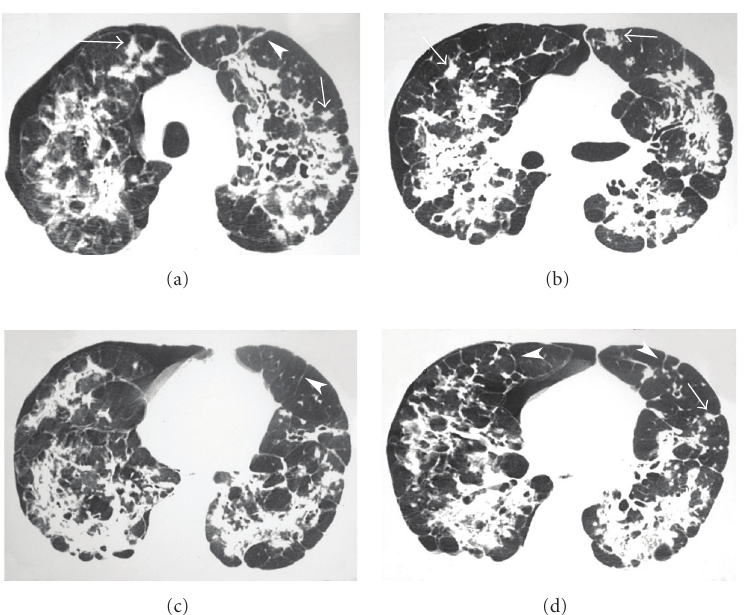
Figure 2: HRCT scans at four di ff erent levels showing areas of consolidation in both lungs, with signs of architectural distortion, irregular nodules (arrows), interlobular septal thickening (arrowheads), and emphysema, in addition to the right